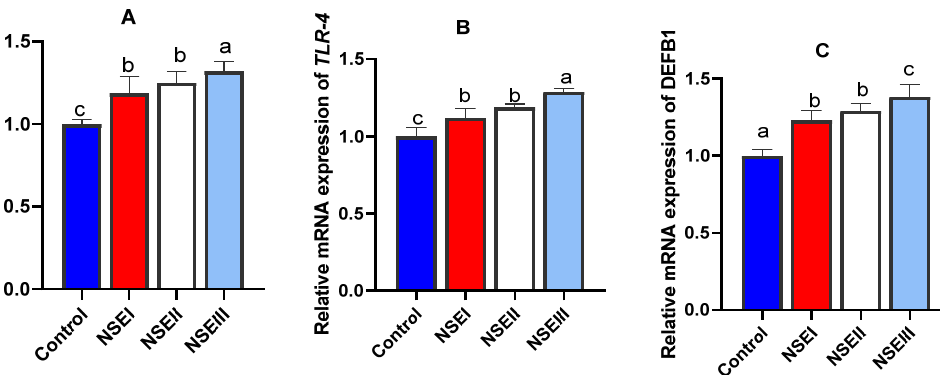
Figure 3. Reverse transcription quantitative real-time PCR analysis of toll like receptor (TLR)-2 ( A ), TLR-4 ( B ) and defensin beta 1 (DEFB1, ( C )) mRNA expression in the spleen of rabbits fed various levels of N. sativa oil extract (NSE) at 60 d of age. Values represent means with their SE in bars. Control: rabbits offered the basal diet, NSEI, NSEII and NSEIII: rabbits fed graded levels of NSE comprising 125, 250 and 500 mg/kg diets, respectively. a–c Means carrying different superscript letters indicate statistical significance ( p < 0.05).